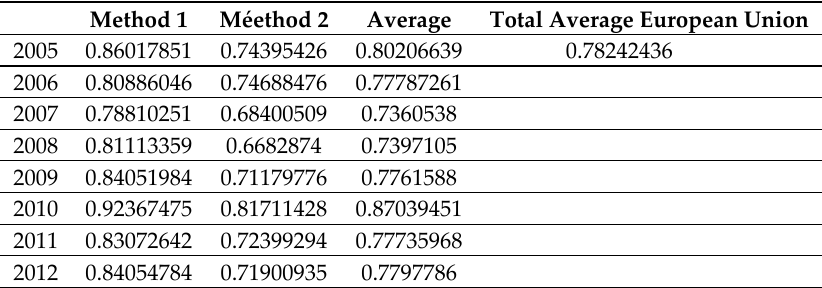
Table 11. Values of average environmental efficiency for the years 2005–2012 obtained with the DEA Method 1 and for Method 2 based on the average environmental efficiency data of the 28 countries of the EU. Average of the values of Methods 1 and 2. Average environmental efficiency value for the total of the European Union. Source: self made.